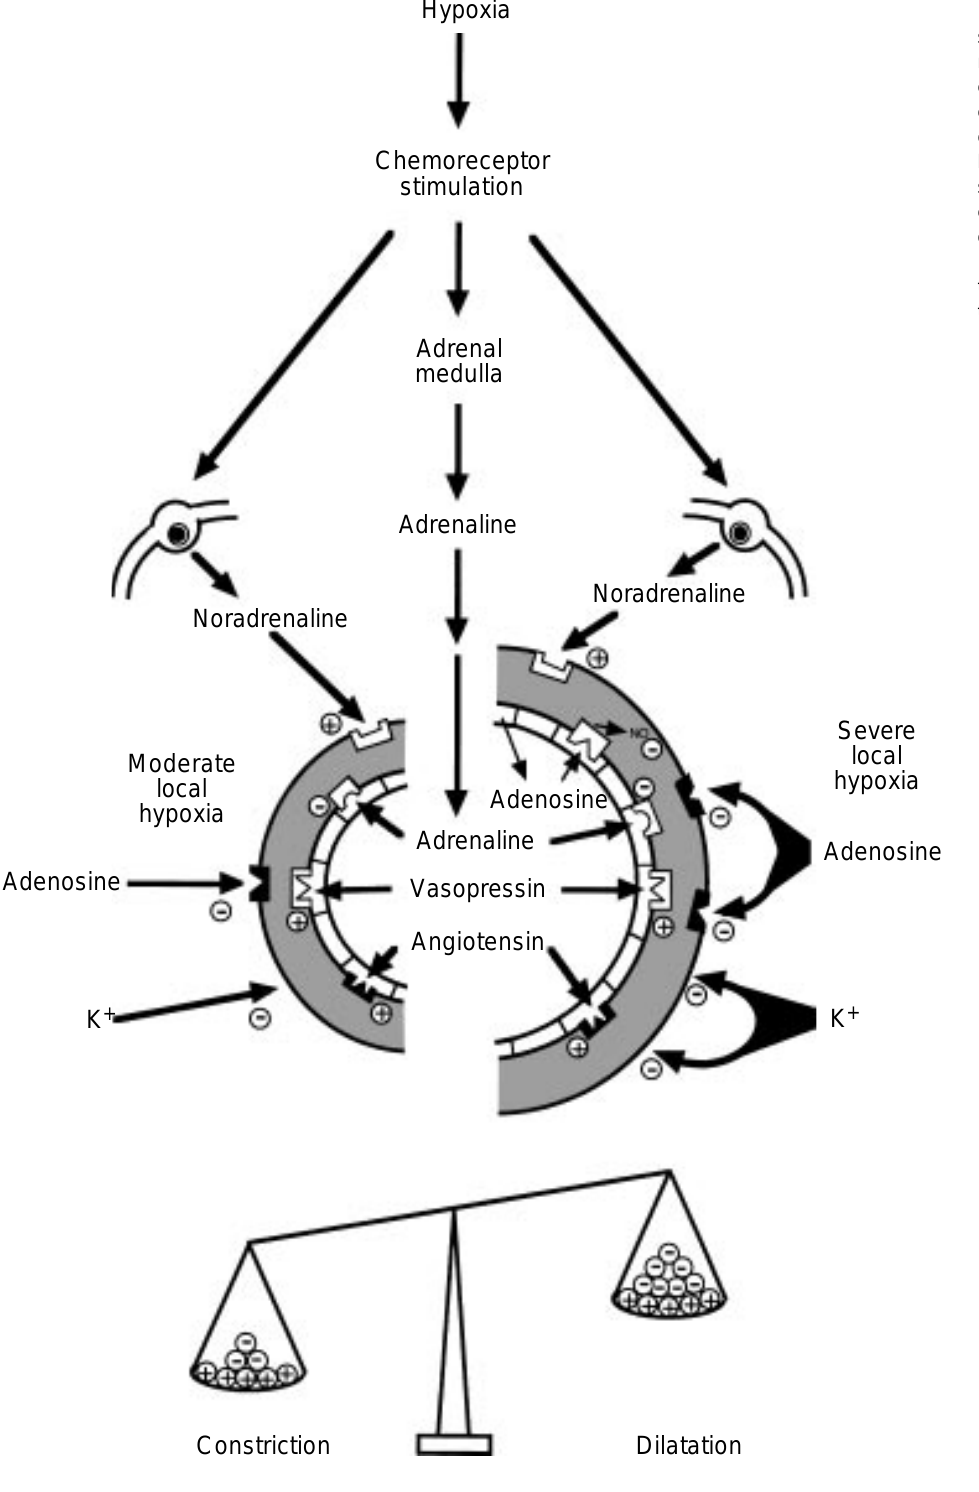
Figure 5 - Schematic diagram showing how the balance of the nerve and hormonally mediated constrictor influences and the lo- cally and hormonally mediated dilator influences of systemic hypoxia on blood vessels within skeletal muscle may be differ- ent depending on the local level of hypoxia. In regions where the level of hypoxia is more severe the balance may be more readily tipped towards vasodilatation. For further discussion see